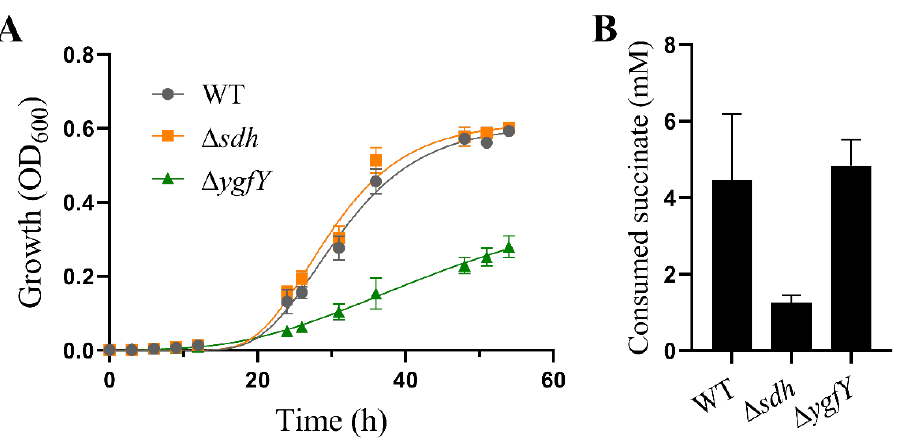
Figure 5. YgfY did not involve in succinate metabolism. ( A ) Growth in the mineral medium with 50 mM lactate and 10 mM succinate. ( B ) Succinate consumption by resting cells for 12 h in the mineral medium containing 10 mM succinate. The data are the mean ± SD ( n = 3). Error bars for some data points were too small to be shown.